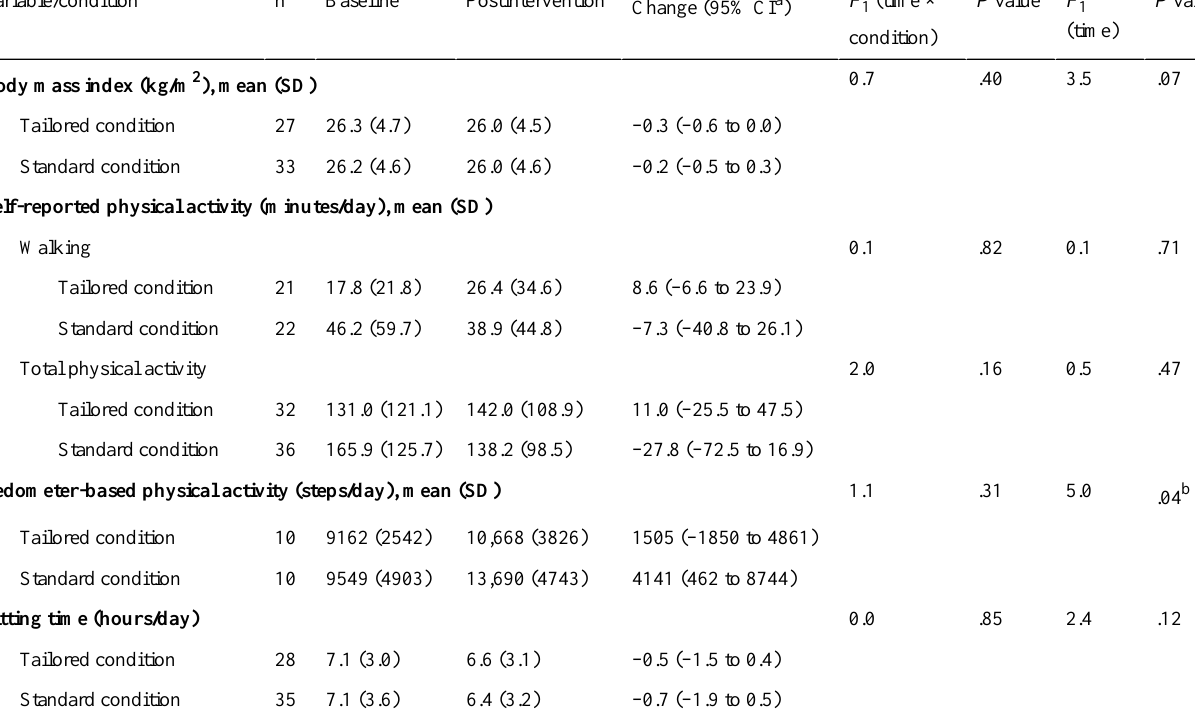
Table 4. Effects on body mass index, physical activity, and time spent sitting in both